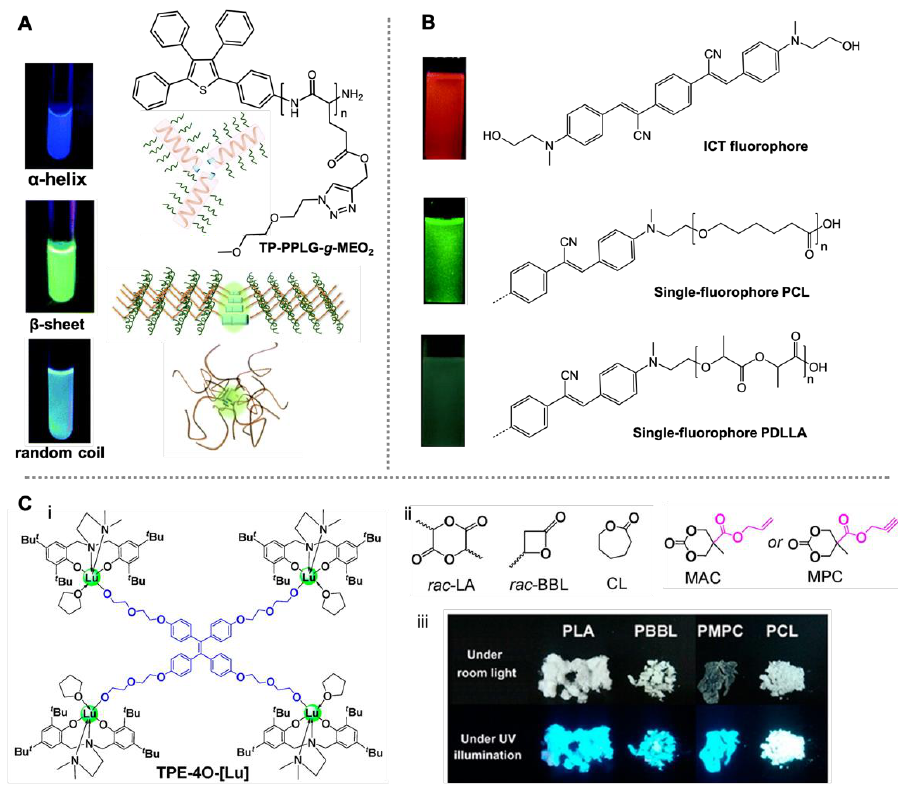
Figure 4. Single-fluorophore AIE polymers prepared by means of ROP. ( A ) Structure and conformation-dependent AIE properties of tetraphenylthiophene- conjugated poly(γ -benzyl-L-glutamate). Reproduced with permission from [73], copyright 2016, Royal Society of Chemistry. ( B ) Structure and polymerization-mediated AIE properties of ICT-based PLA and PCL. Reproduced with permission from [82], copyright 2014, Royal Society of Chemistry. ( C ) Structure of TPE-attached salan lutetium alkoxide complex (i) and the monomers for polymer synthesis (ii), as well as the photographs of the polymer powders under UV irradiation (iii). Reproduced with permission from [86], copyright 2014, American Chemical Society.